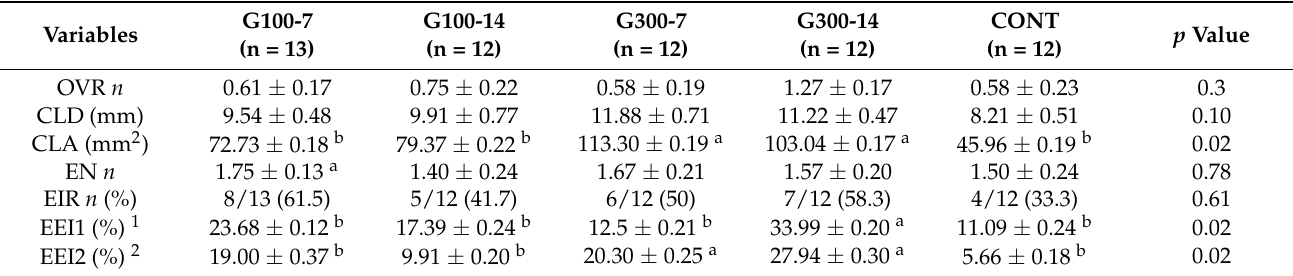
Table 3. Least-square means ± standard error for ovulation rate (OVR), corpus luteum diameter (CLD), corpus luteum area (CLA), embryo number (EN), embryo implantation rate (EIR), embryo efficiency index-1(EEI-1) and embryo efficiency index-2 (EEI-2), according to the experimental treatment considering two doses of hCG (100 and 300 IU), and applied at two different times (7 and 14 d), and the Control group (CONT) after a fixed time artificial insemination protocol in multiracial, multiparous, and anovulatory goats (n = 61, Alpine, Saanen, Nubian x Criollo) managed under extensive conditions in Northern Mexico (April, 25 ◦